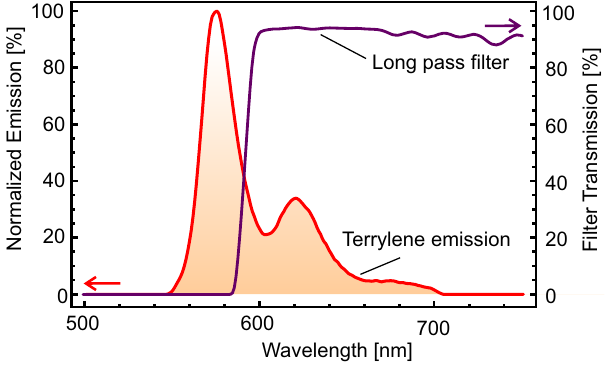
Figure 4. Emission spectrum of terrylene molecules. The optimal spectral filtering utilizes